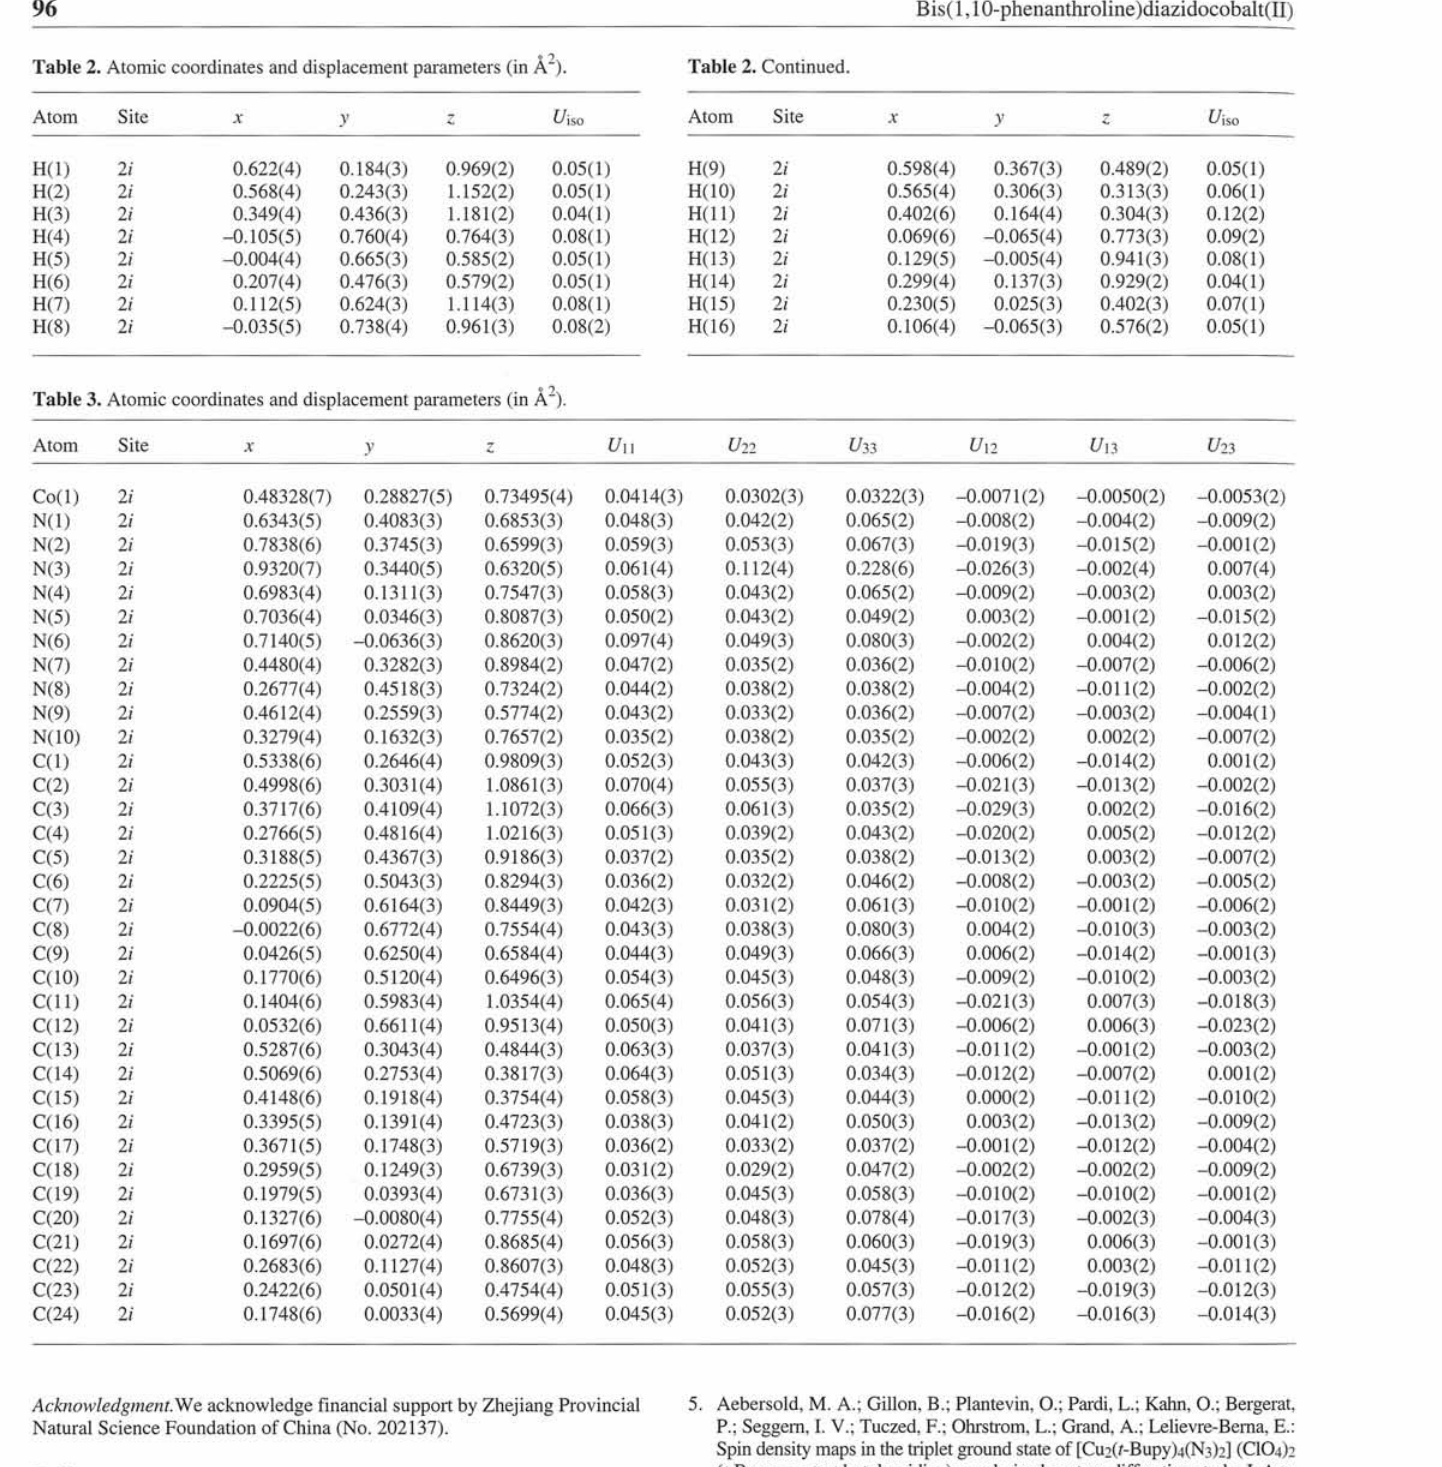
Table 2. Atomic coordinates and displacement parameters (in A").